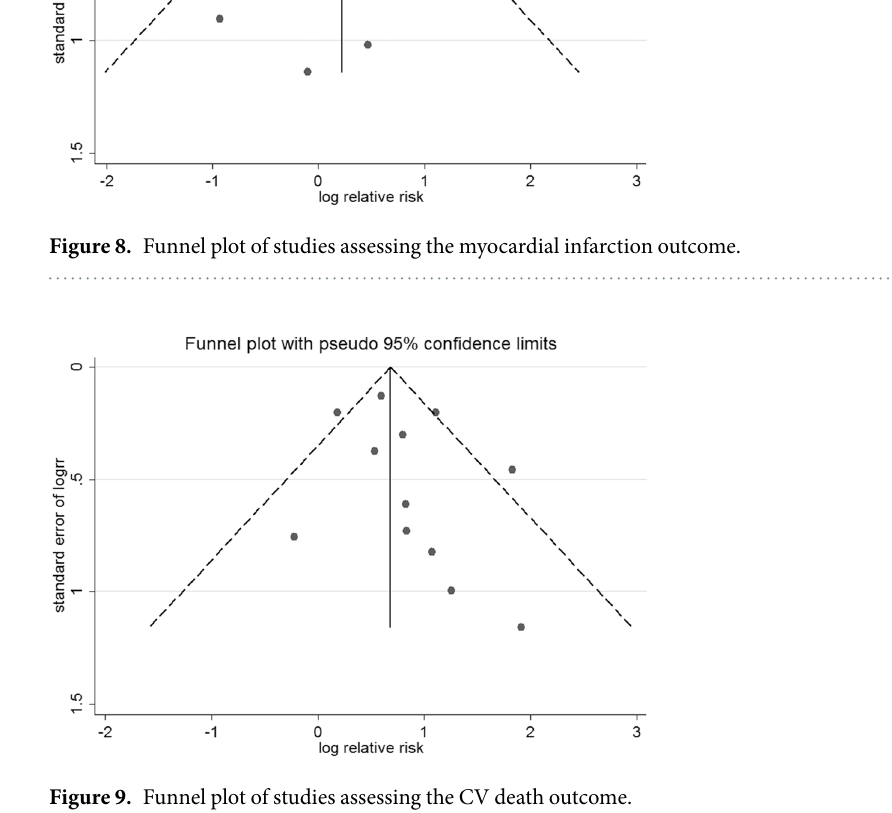
Figure 9. Funnel plot of studies assessing the CV death